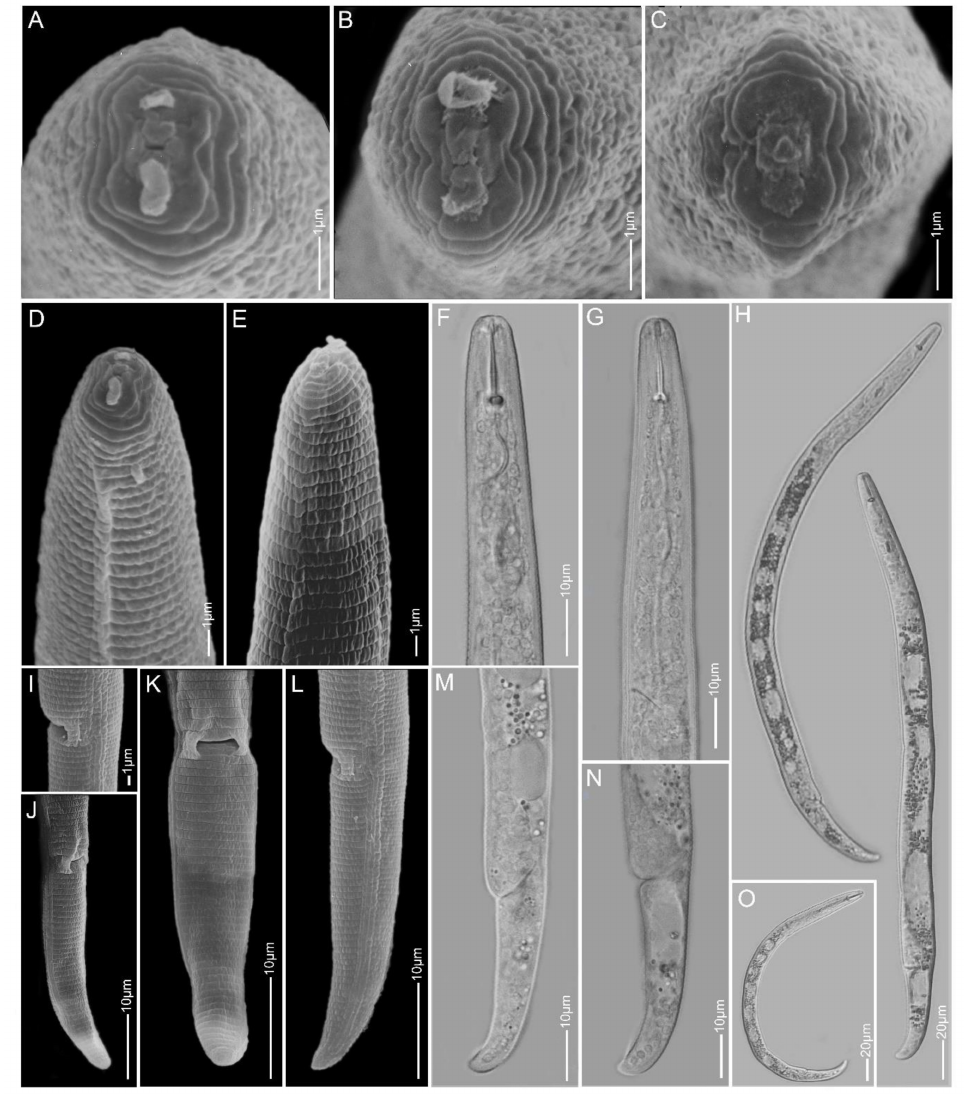
Figure 11. Light and scanning electron microscopy images of Paratylenchus veruculatus females: ( A – C ) face view; ( D – G ) anterior region; ( H , O ) total body; ( I – N ) lateral field and tail